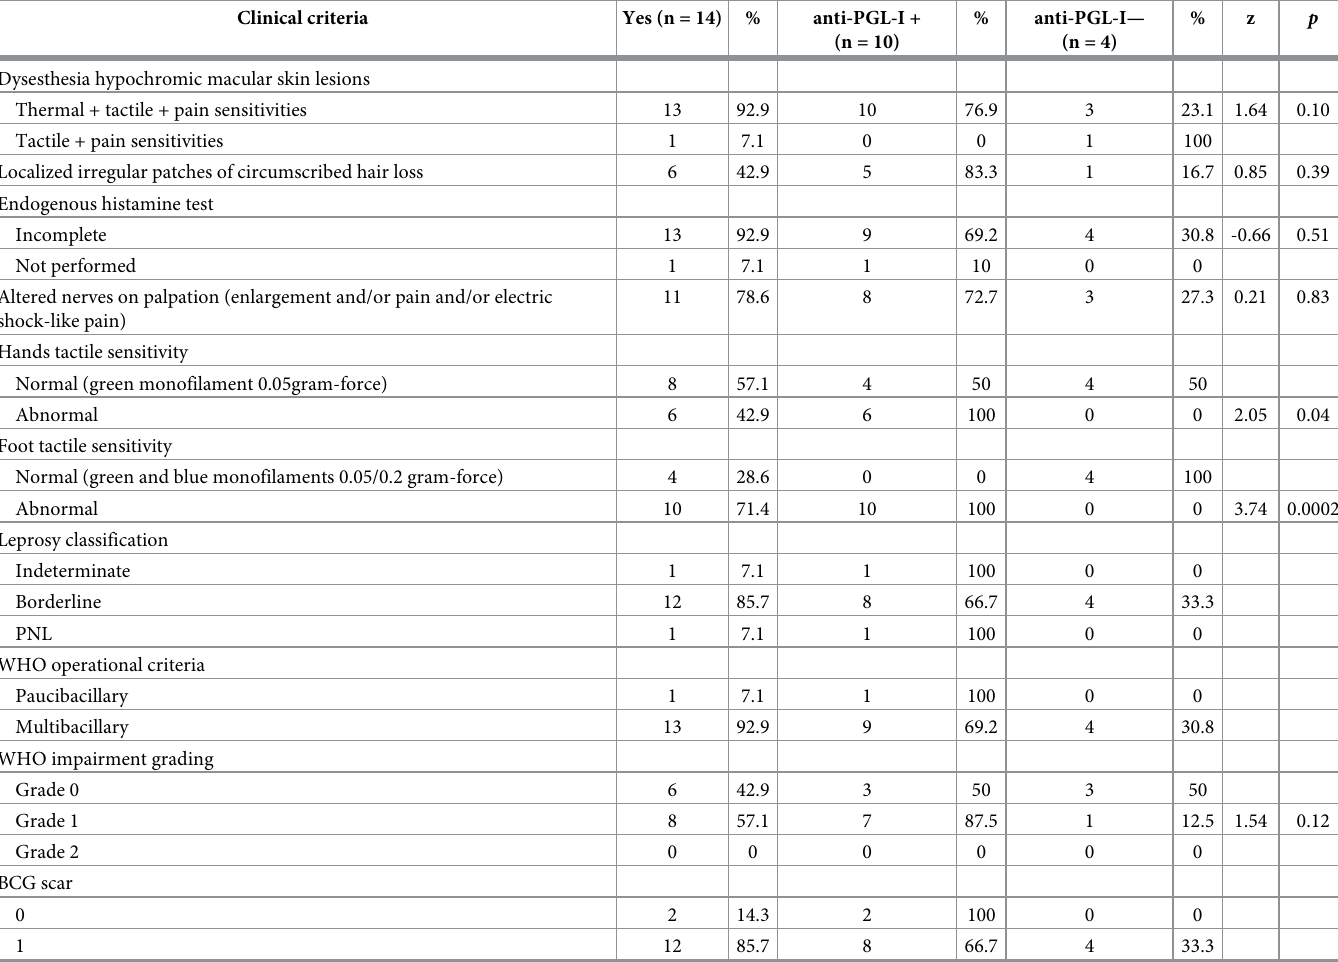
Table 4. Clinical characterization of Ribeir ã o Preto Female Penitentiary patients regarding the percentage of positivity to the clinical criteria used for the diagnosis of leprosy (n = 14) distributed according to the anti-PGL-I results. Clinical